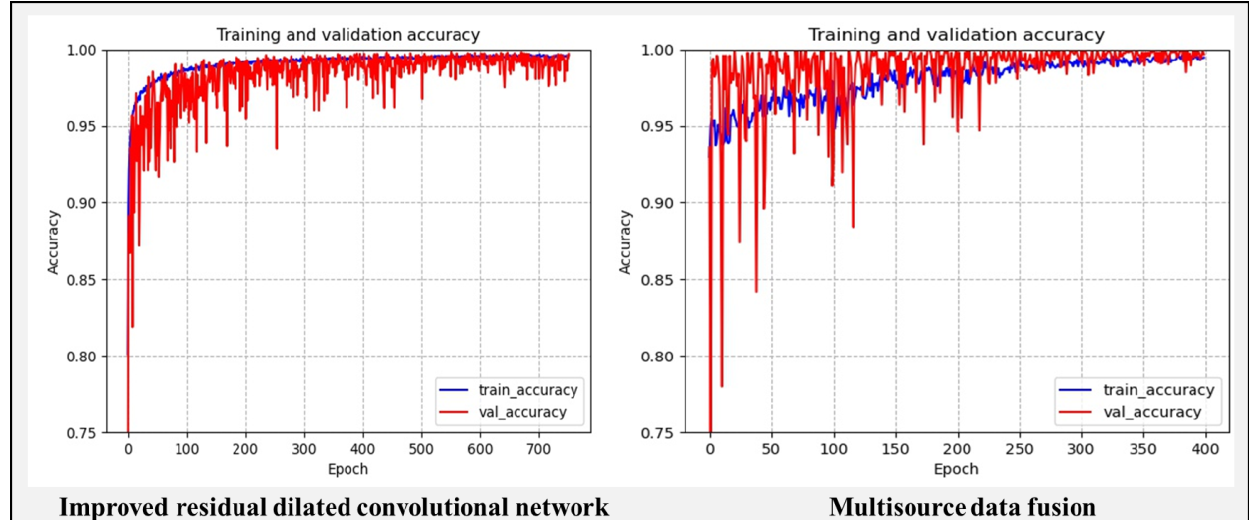
Figure 19. Comparison of the accuracy and convergence performance of the two